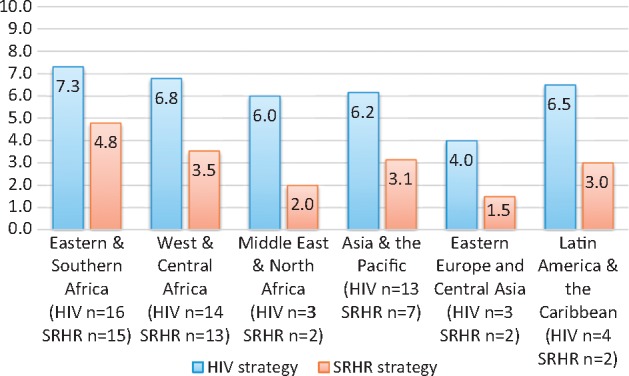
Scores (/10) by region